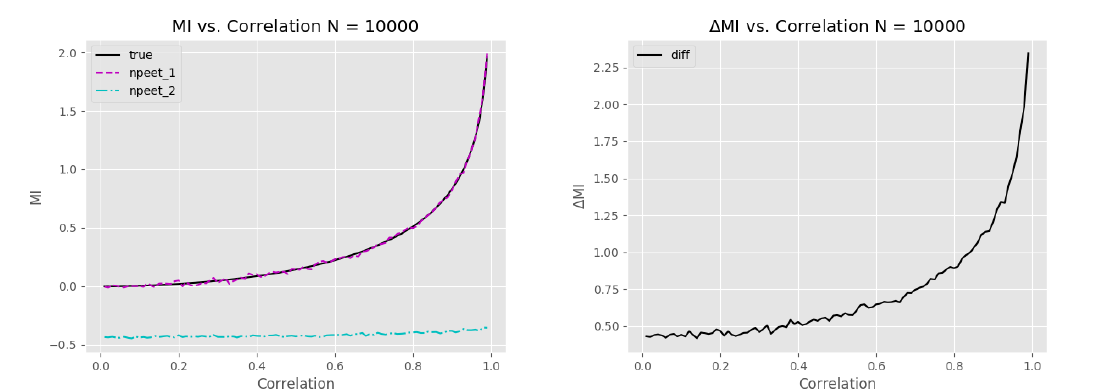
Figure 1. Comparison of mutual information estimates KSG for a bivariate normal distribution before (npeet_1) and after (npeet_2) a linear transformation of one variable by a factor of 10 5 . The second plot shows the difference between (npeet_1) and